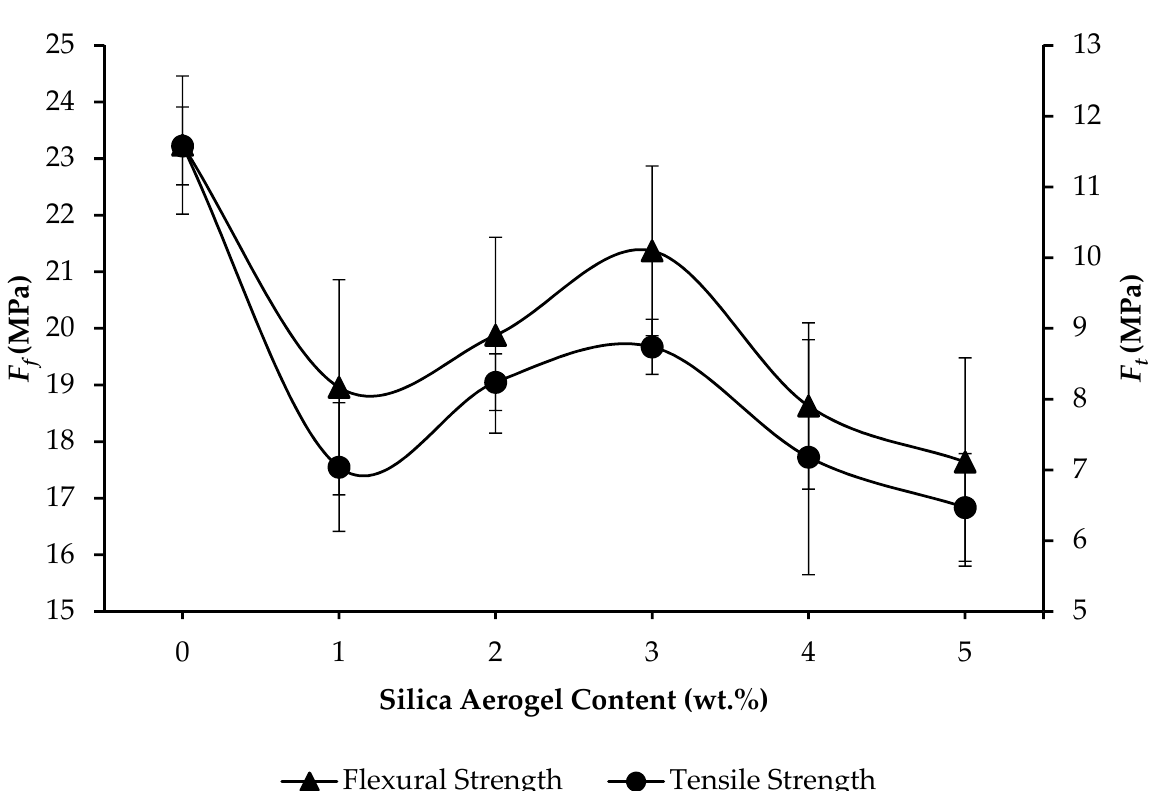
Figure 10. Flexural strength ( F f ) and tensile strength ( F t ) for the composite insulation materials.